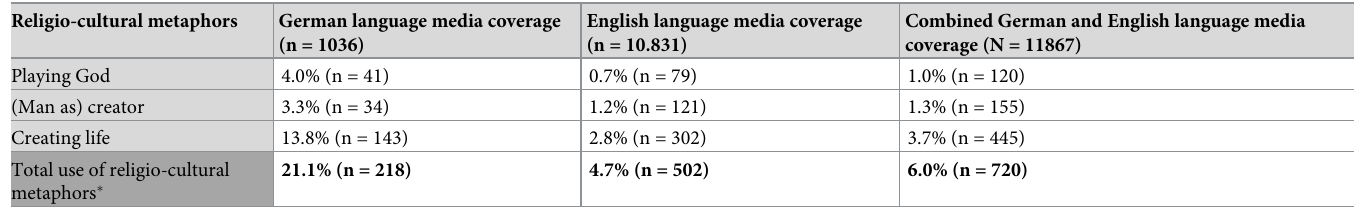
Table 1. Frequencies of most-used religio-cultural metaphors in the field of SB in German and English language media coverage 2004–2015 (in percent). Religio-cultural